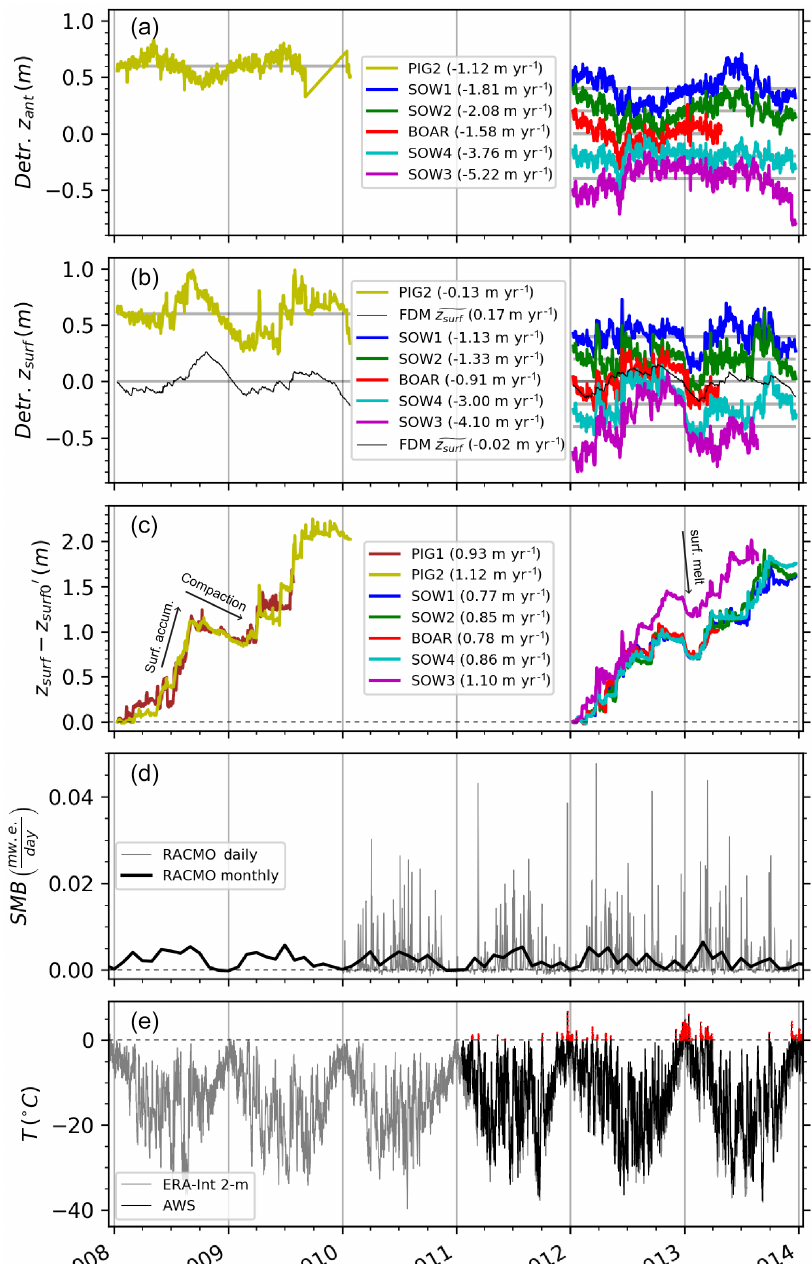
Figure 9. (a) Detrended GPS antenna elevation ( z ant , see Fig. 7b for original records), with arbitrary y -axis offset. The legend lists linear trends, which can be compared with D z surf / D t trend in panel (b) (see Eq. 6). (b) Detrended surface elevation ( z surf , see Fig. 7c) and detrended IMAU-FDM simulated surface elevation ( g z surf ) , with arbitrary y -axis offset. The legend lists linear trends. Note limited residual magnitude and dampened seasonal signal of z ant compared to z surf . Unlike z surf , no significant change is observed in z ant from December 2012 to January 2013. (c) Surface elevation relative to tracer for initial surface ( z surf − z surf0 (cid:48) ). As annotated, positive slopes are indicative of new snow accumulation, shallow negative slopes indicate ongoing compaction, and steep negative slopes likely indicate surface melt. Note ∼ 0.2– 0.3m surface decrease from December 2012 to January 2013. Legend values show linear fit at each site. (d) Daily and monthly RACMO2.3 SMB. Note correlation of accumulation events and increases in panel (c) . (e) Scaled 2m temperature data from Evans Knoll AWS (black) and ERA-Interim (gray), with above-zero AWS temperatures plotted in red. Note extended warm period from mid-December 2012 to mid- January 2013, which corresponds to ∼ 0.2–0.3m surface elevation decrease in panels (b) and (c) .